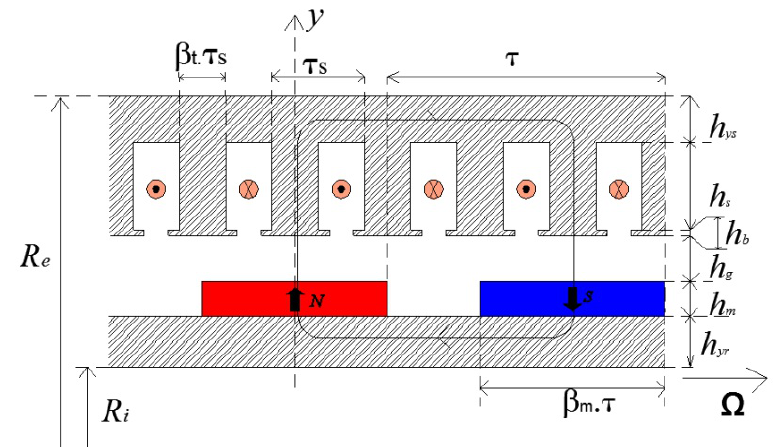
Figure 11. Basic dimensions of one pair of poles